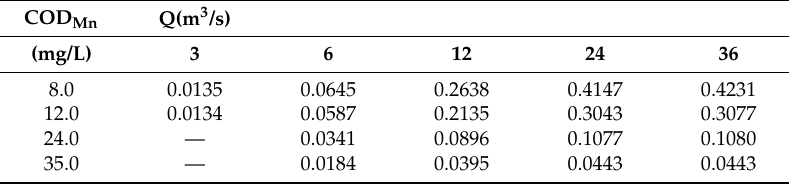
Table 8. The typical values of exceedance probability of COD Mn